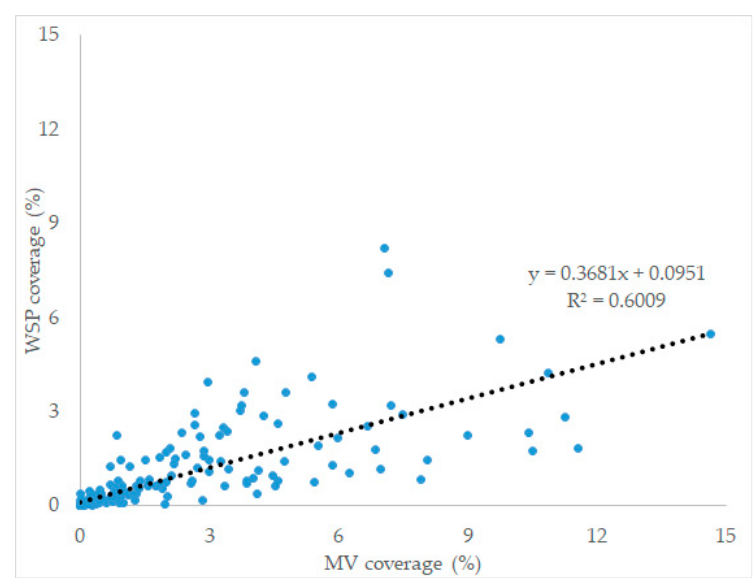
Figure 7. Correlation analysis between MV and WSP coverage.